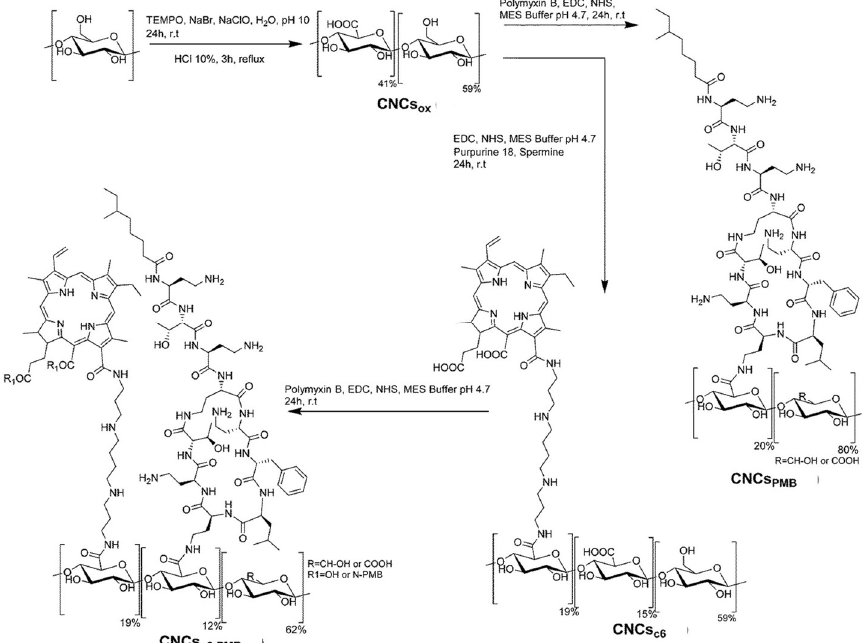
Figure 12. Synthetic route to cellulose nanocrystals CNCs c 6 - PMB coated with chlorin- e6 and polymyxin B and to cellulose nanocrystals CNCs PMB just coated with polymyxin B. Reprinted with permission from Ref. [67] . 2017, The Royal Society of Chemistry.